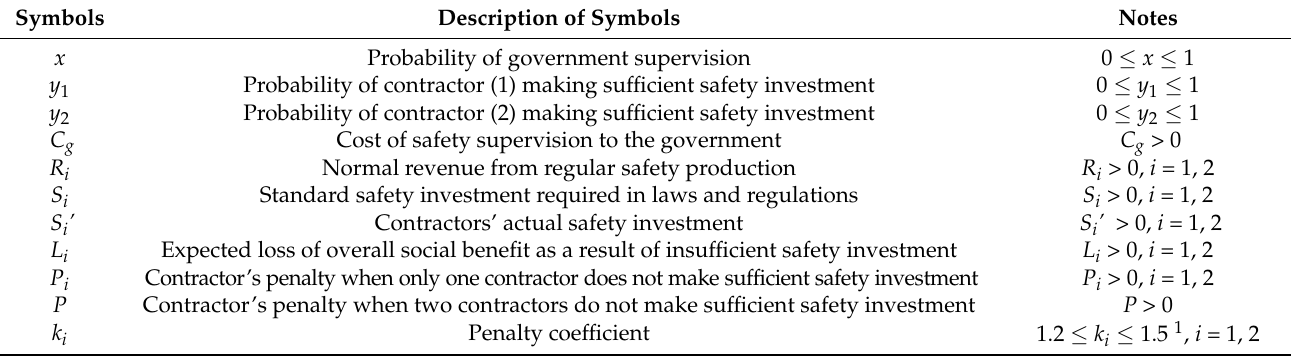
Table 1. Meanings of the variables in the multiplayer